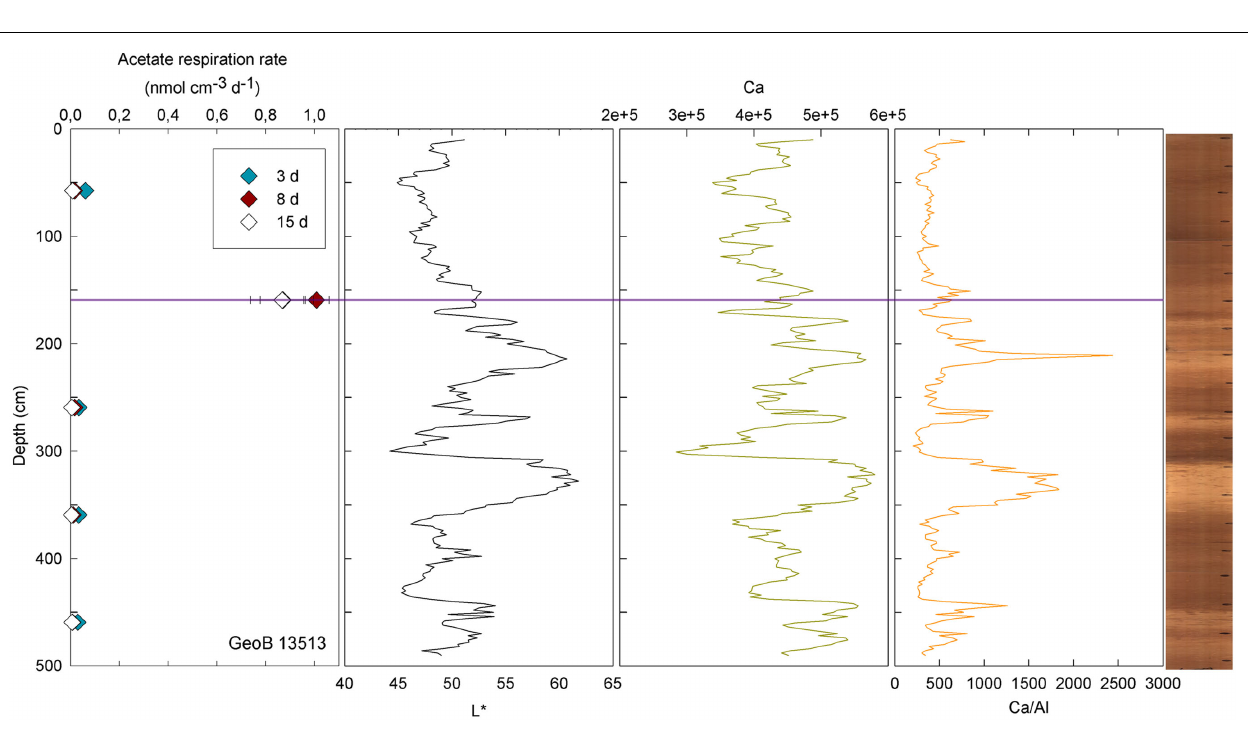
FIGURE 5 | GeoB 13513 linked activities and lithological features. Purple line denotes depth of greater potential acetate turnover. Samples were taken at depths 57.5, 159.5, 259.5, 359.5, and 459.5cm.